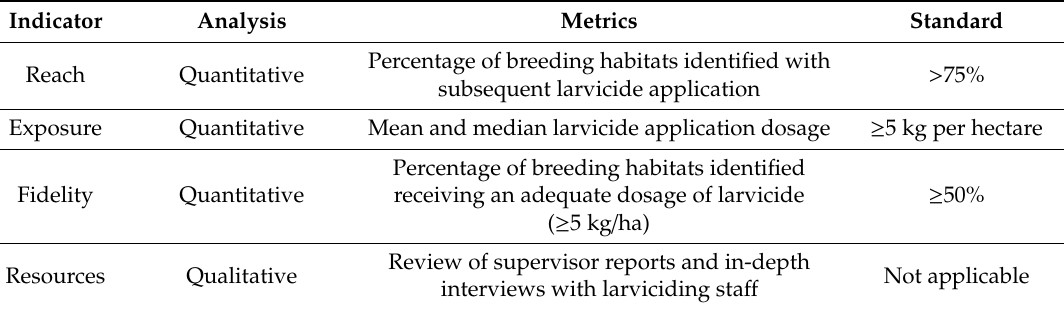
Table 1. Indicators and analysis methods